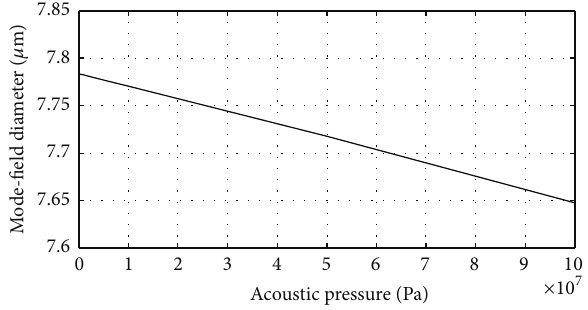
Figure 6: The calculated mode-field diameter of the investigated HC-PBF as a function of the acoustic pressure at acoustic frequency 10